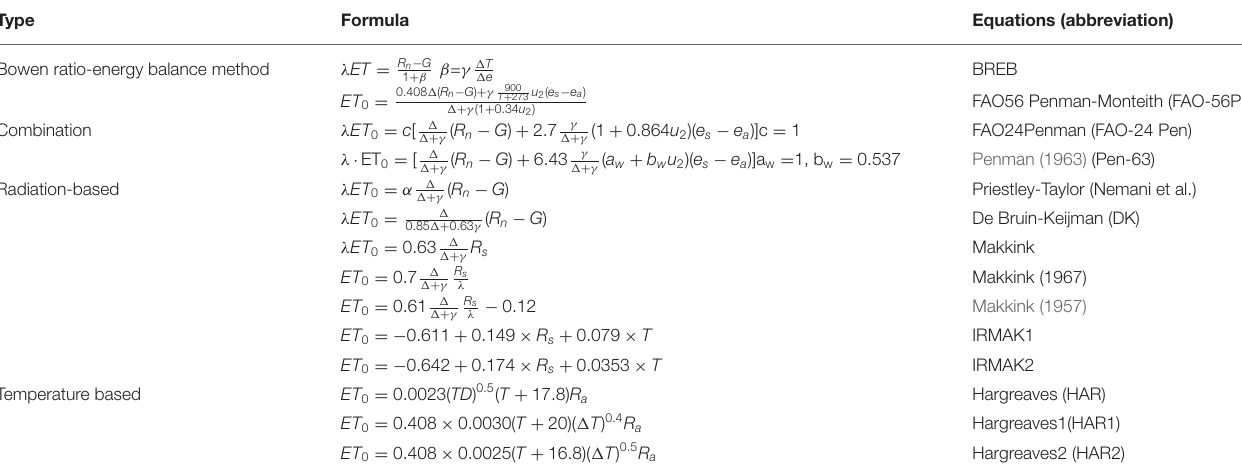
TABLE 2 | Details of selected models for evaluation and input parameters in each model.